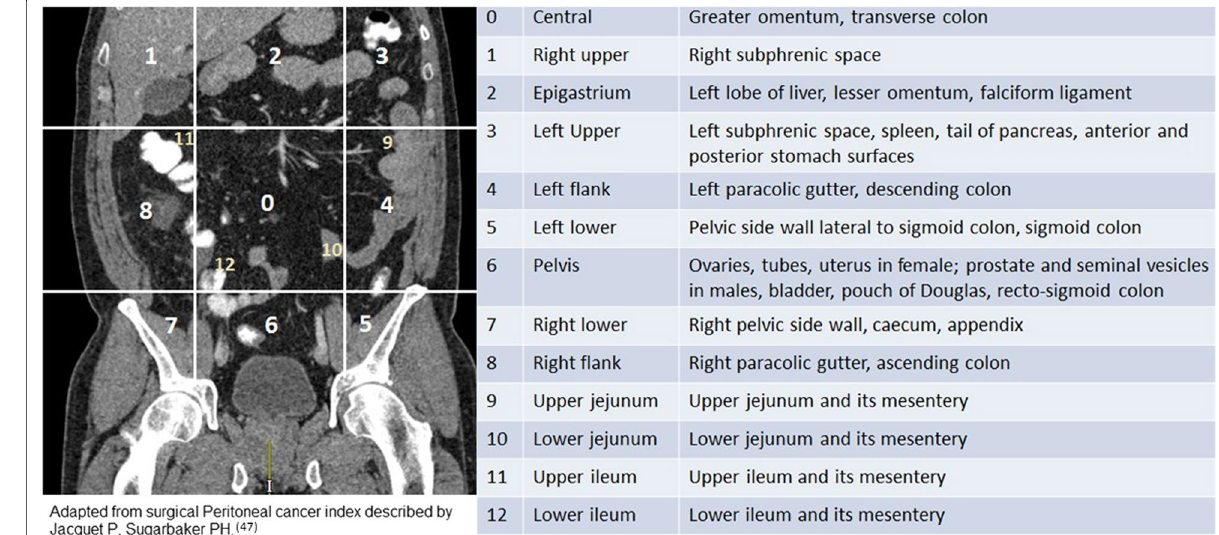
Fig. 11 Radiological peritoneal cancer index (rPCI) adapted from surgical peritoneal cancer index (PCI) described by Jacquet et al. [47]. This figure is being reused from author’s prior work published in clinical radiology [44] with permission from Elsevier